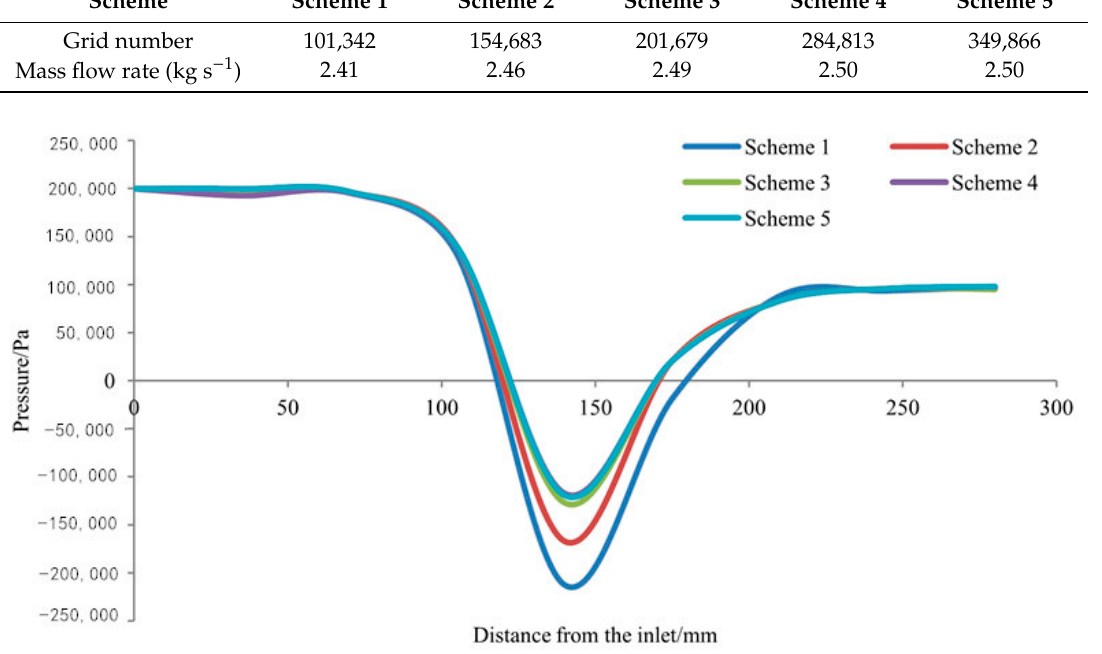
Figure 3. Static pressure distribution along the axial.